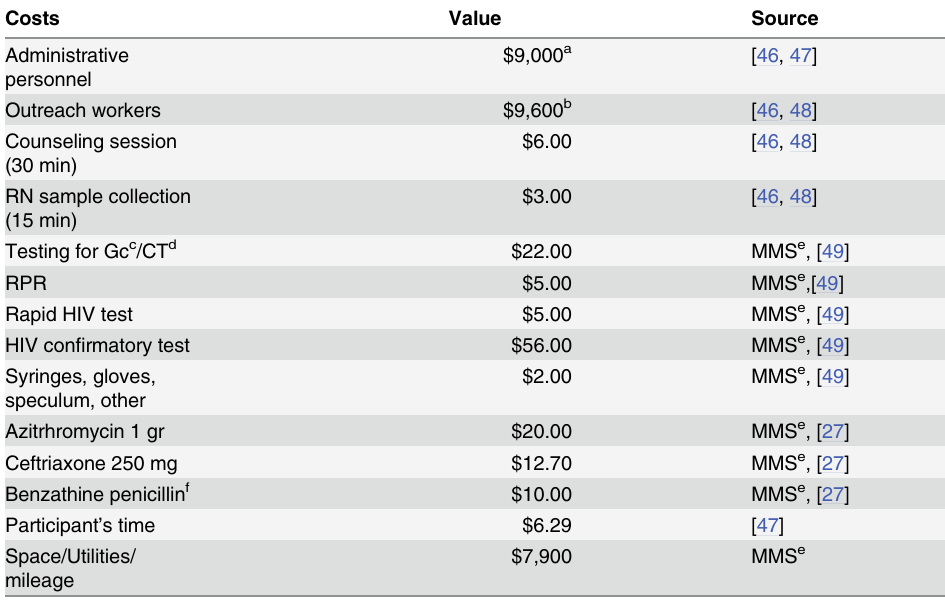
Table 3. Costs associated with the Mujer Mas Segura